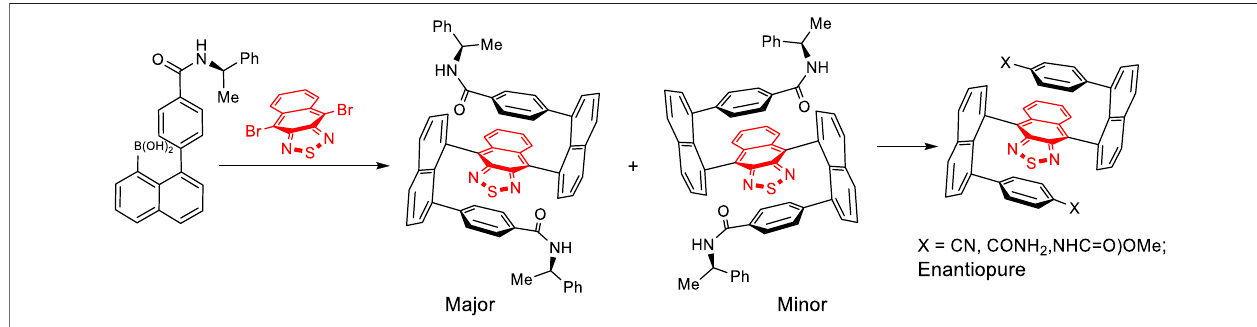
SCHEME 1 | Asymmetric synthesis of multilayer chiral folding molecules.